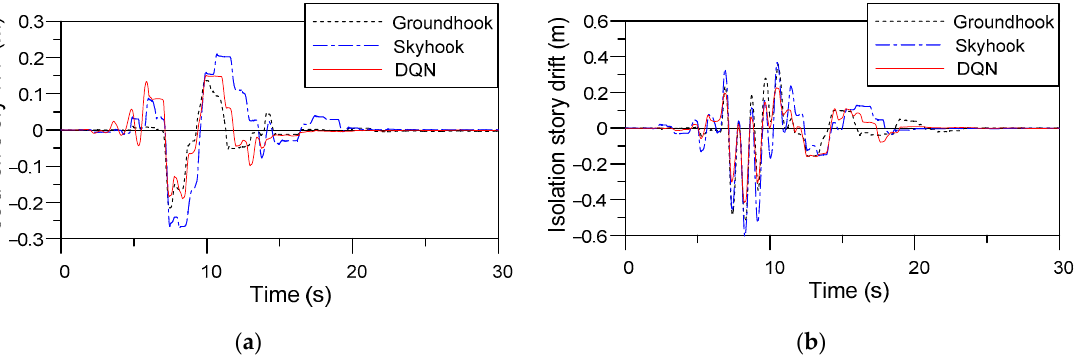
Figure 14. Comparison of the isolation story drift time histories: ( a ) responses to EV1, ( b ) responses to EV2.